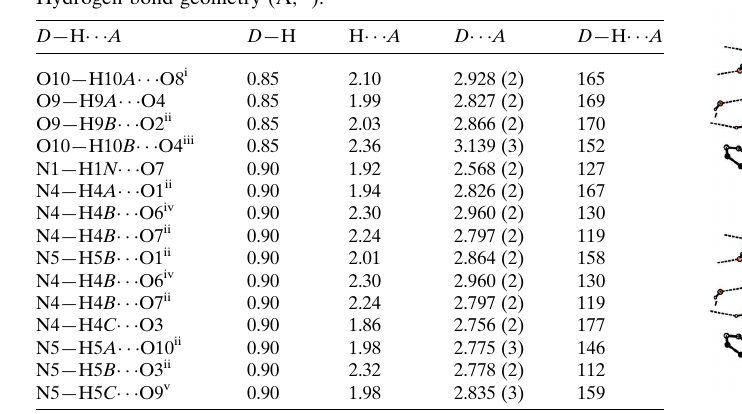
Table 1 Hydrogen-bond geometry (A˚ , (cid:4)